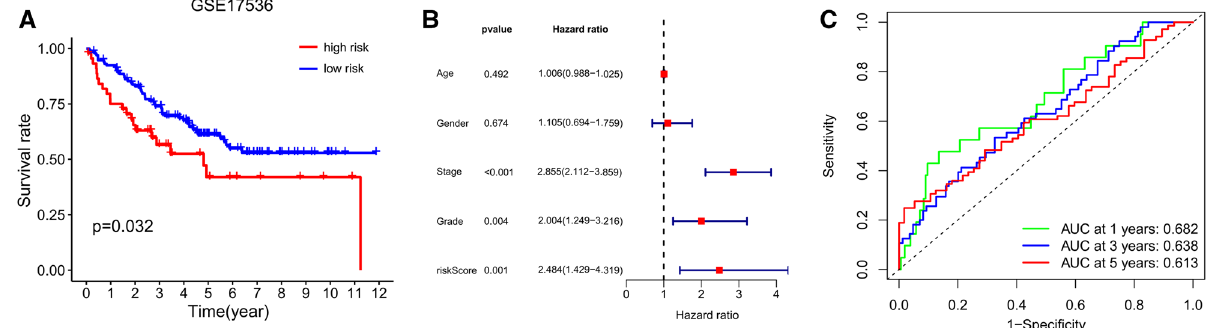
Figure 3. Validation of the immune-related lncRNA signature in external test cohort. ( A ) Kaplan–Meier survival curve of patients with CRC in high- and low-risk groups in GSE17536 cohort. ( B ) Cox analysis of prognostic factors in GSE17536 cohort. ( C ) Time-dependent ROC curve for predicting 1-, 3- and 5-year survival in GSE17536